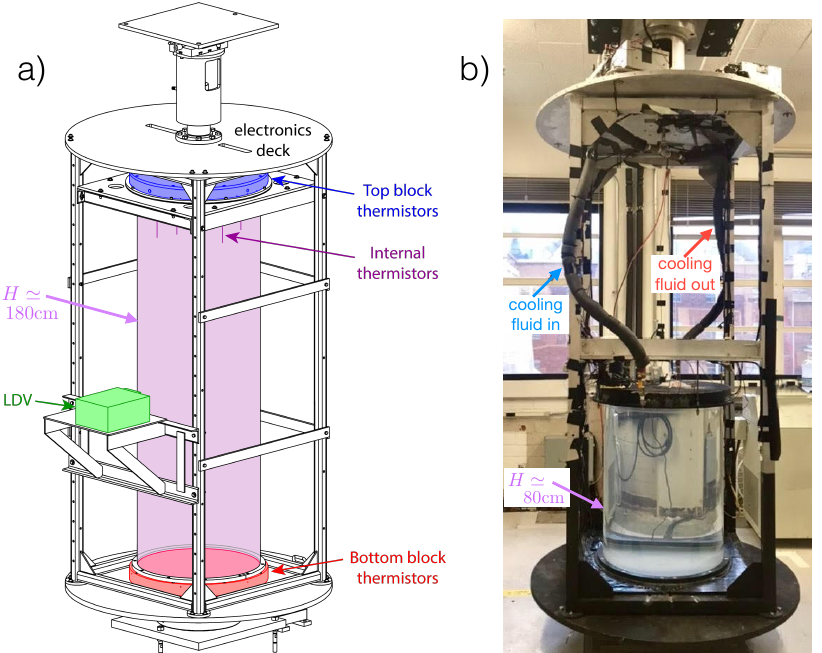
Figure 3. ( a ) Schematic of the NoMag laboratory device with the H = 1.85 m acrylic container (purple). Diagnostic systems of the device include: (i) temperature measurements at the top (blue) and bottom (red) of the fluid boundaries; (ii) internal fluid temperature measurements (purple); (iii) point velocity measurements via laser Doppler velocimetry (LDV) (green). All electronics, including those used for data acquisition, are mounted onto the upper table structure in the rotating frame of the device and are labeled in black. ( b ) An image of the device with the H = 0.802 m tank filled with water. The inlet (outlet) cooling fluid channel of the heat exchanger in the top thermal block is labeled in blue